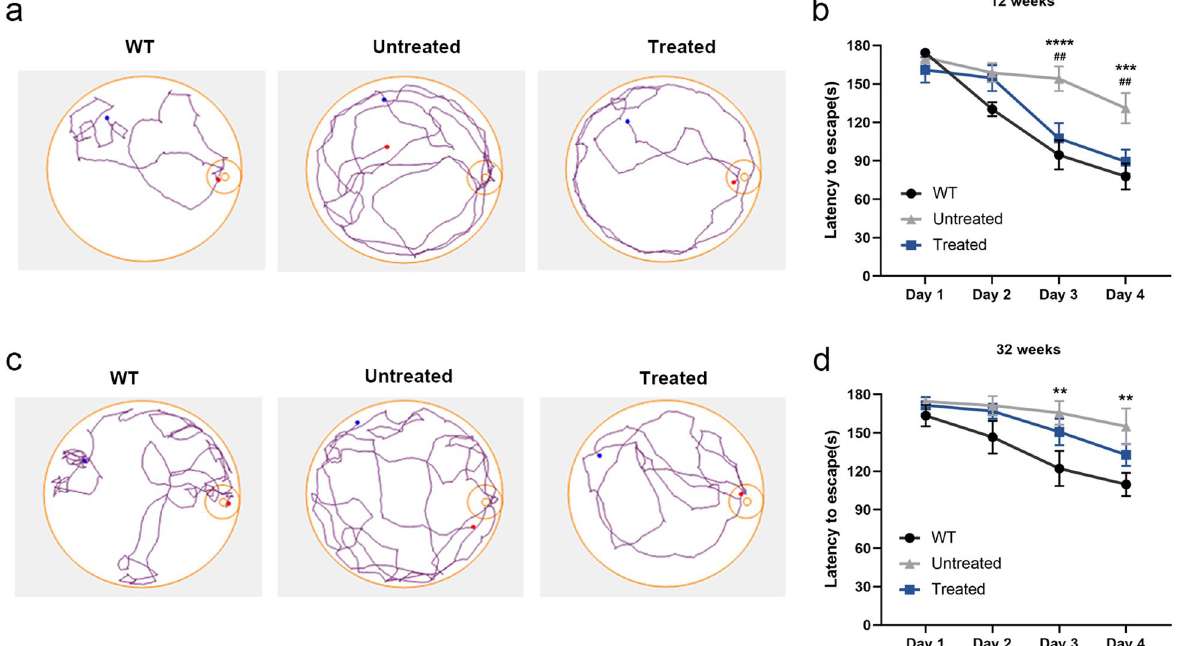
Fig. 6 In vivo base editing prevents neurobehavioral deficit in MPS IH mice. Performance in the DMP dry maze is the time to escape from the maze. a Representative escape traces of 12-week-old mice in each group in the DMP dry maze. The blue dots indicate the original position of the mouse, and the red dots indicate the final position. b Quantitative analysis of average escape time after training in 12-week-old mice. Data were shown as mean SEM at each time point. WT mice ( n 6), untreated MPS IH mice ( n 6) and treated MPS IH mice ( n 5). c Representative escape traces of ± = = = 32-week-old mice in each group in the DMP dry maze. d Quantitative analysis of average escape time after training in 32-week-old mice. Data were shown as mean SEM at each time point. WT mice ( n 7), untreated MPS IH mice ( n 7) and treated MPS IH mice ( n 7). ( b , d ) The WT mice were ± = = = compared with the untreated MPS IH mice, ** p < 0.01, *** p < 0.001, **** p < 0.0001. The treated MPS IH mice were compared with the untreated MPS IH mice, ## p < 0.01, one-way ANOVA analysis with Tukey’s post-hoc